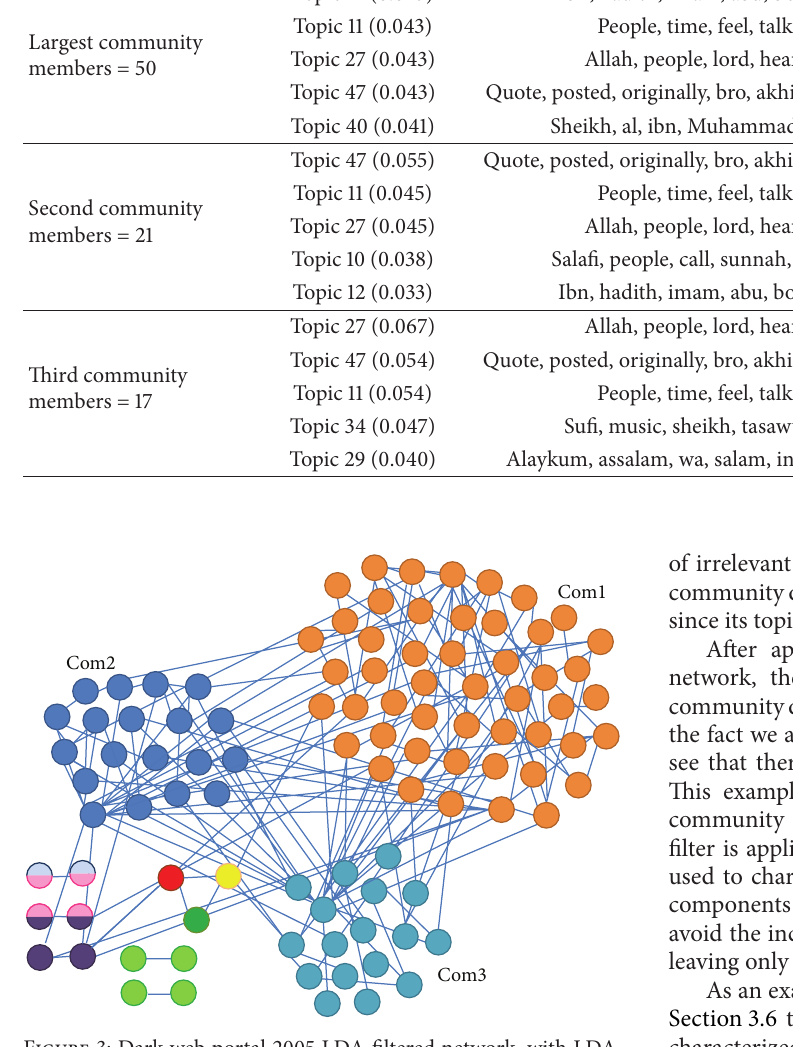
Figure 3: Dark web portal 2005 LDA-filtered network, with LDA- Filter